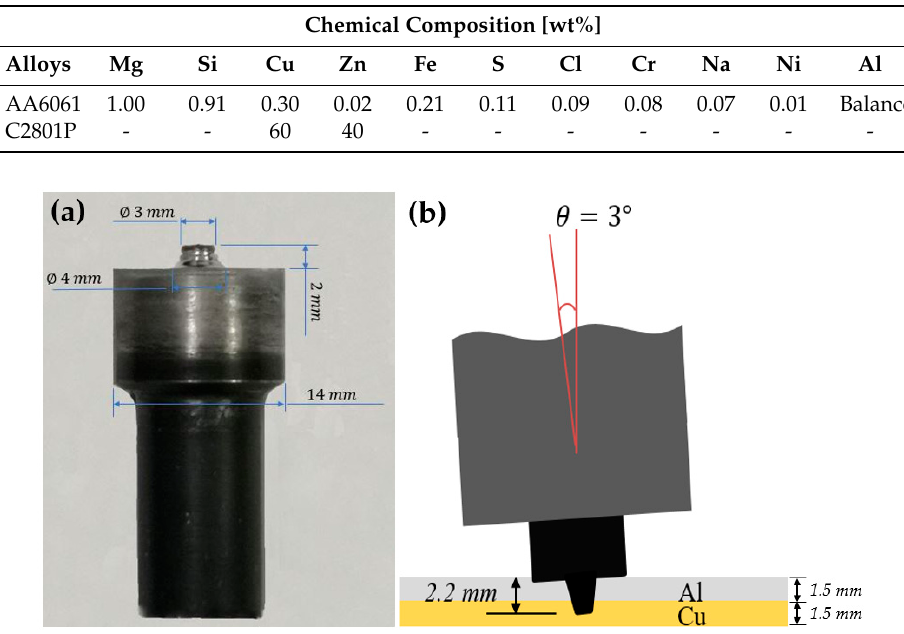
Figure 1. Schematic diagram of ( a ) tilt angle and plunge depth during the welding process and ( b ) the friction stir-welding (FSW) tool.